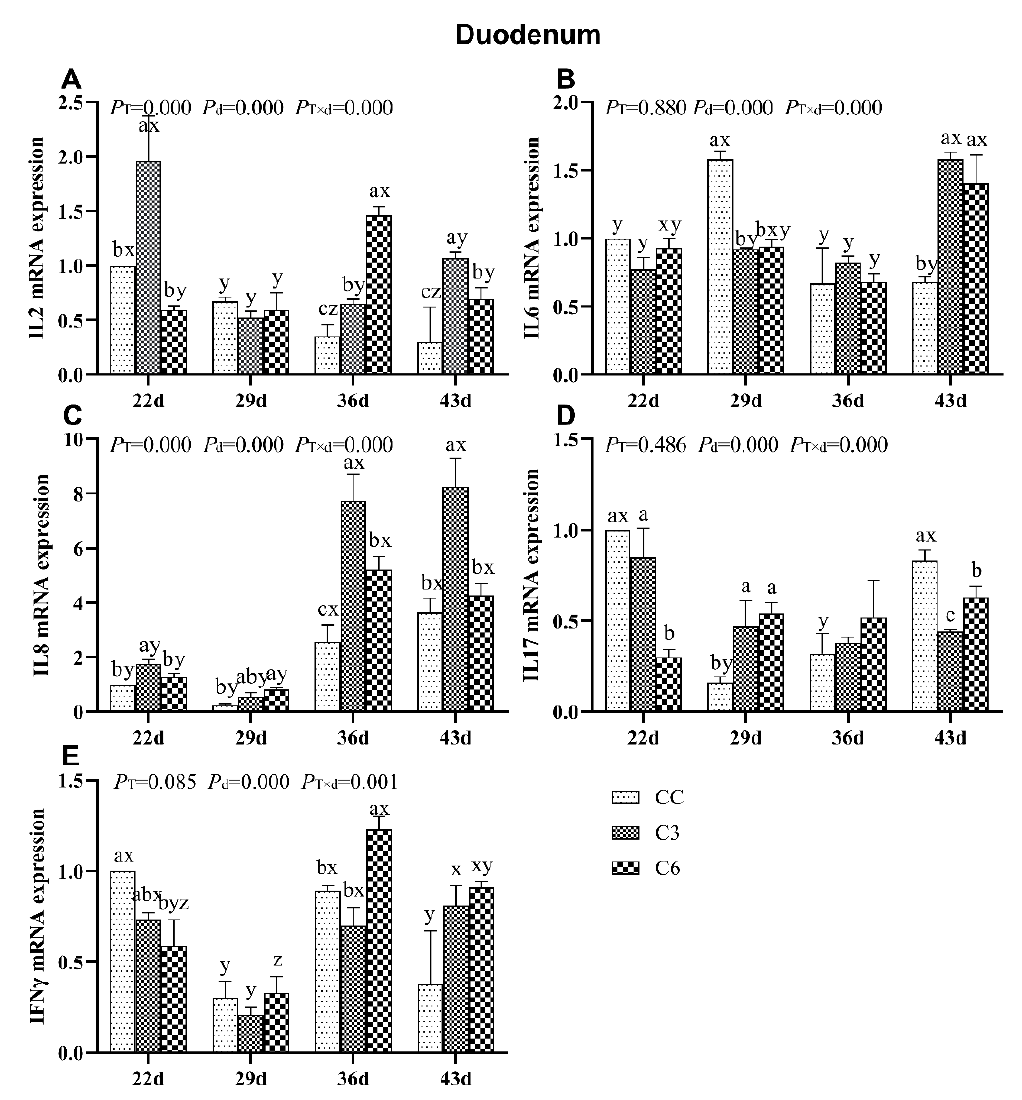
Figure 3. mRNA levels of cytokines IL2 ( A ), IL6 ( B ), IL8 ( C ), IL17 ( D ), and IFNγ ( E ) in the duodenum of broilers. Different letters indicate significant differences ( p < 0.05) between treatment groups (a, b, c) and days of age (x, y, z).